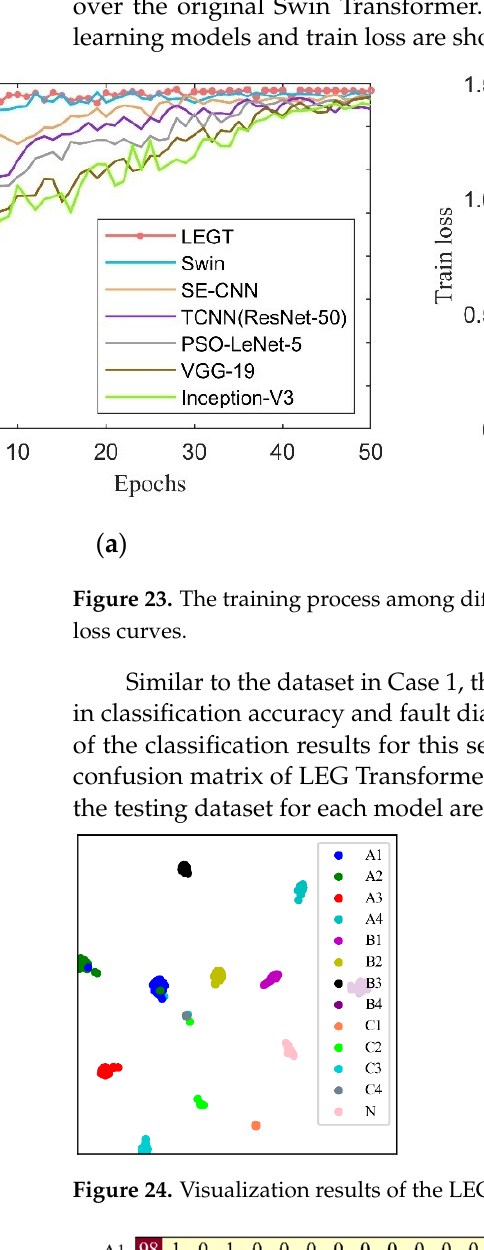
Table 9. The results of the testing dataset in different models (%).